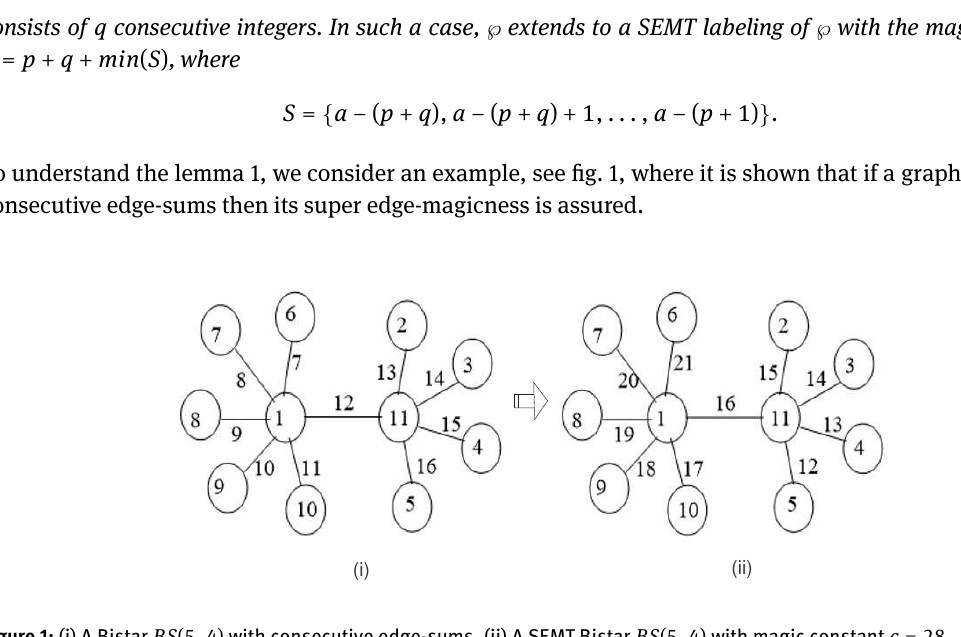
Figure 1: (i) A Bistar BS (5, 4) with consecutive edge-sums, (ii) A SEMT Bistar BS (5, 4) with magic constant c =